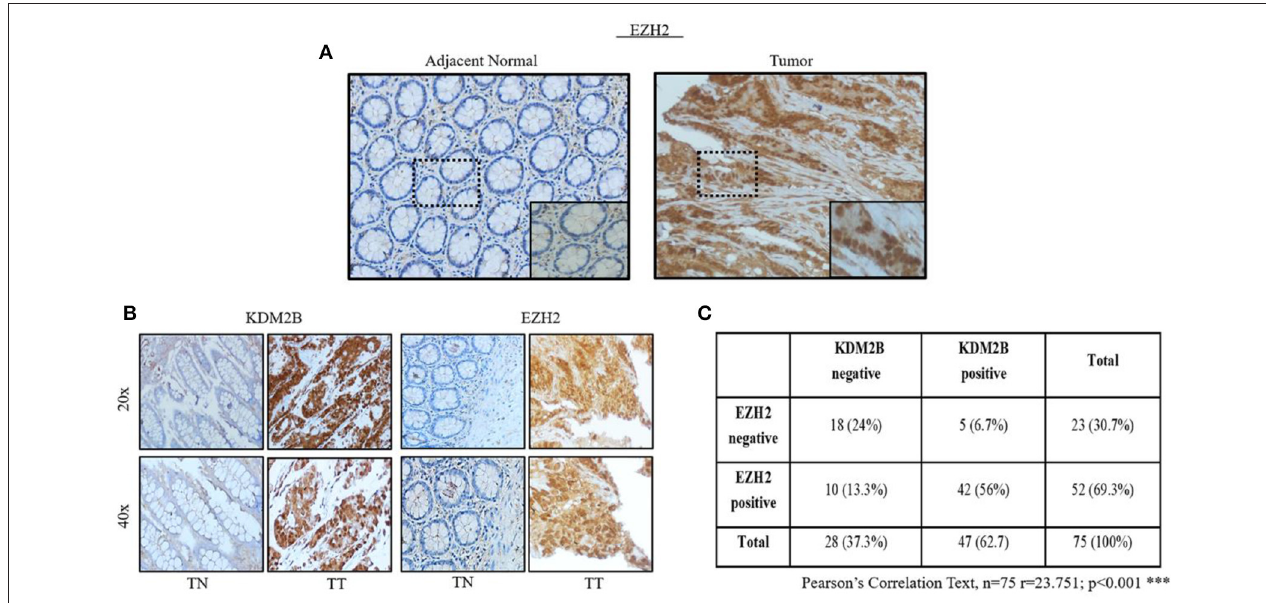
FIGURE 7 | The expressions of EZH2 is positively related to KDM2B in tissues with CRC. (A) Representative images of the expression of EZH2 in adjacent normal tissue specimens with CRC vs. tumor tissue. (B) The expression of KDM2B and EZH2B proteins in TMA tissue sections was represented by the cohort. The magnification was × 20 and × 40, respectively. Scale bar = 100 µ m. (C) The negative correlation of KDM2B with the expression of EZH2 was assessed using the chi-square Pearson correlation text ( n = 75; r = 23,751; *** p <